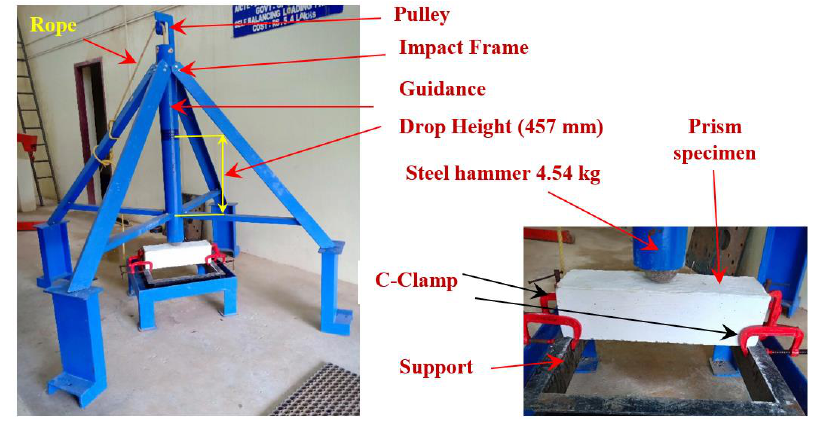
Figure 5. Impact testing device.